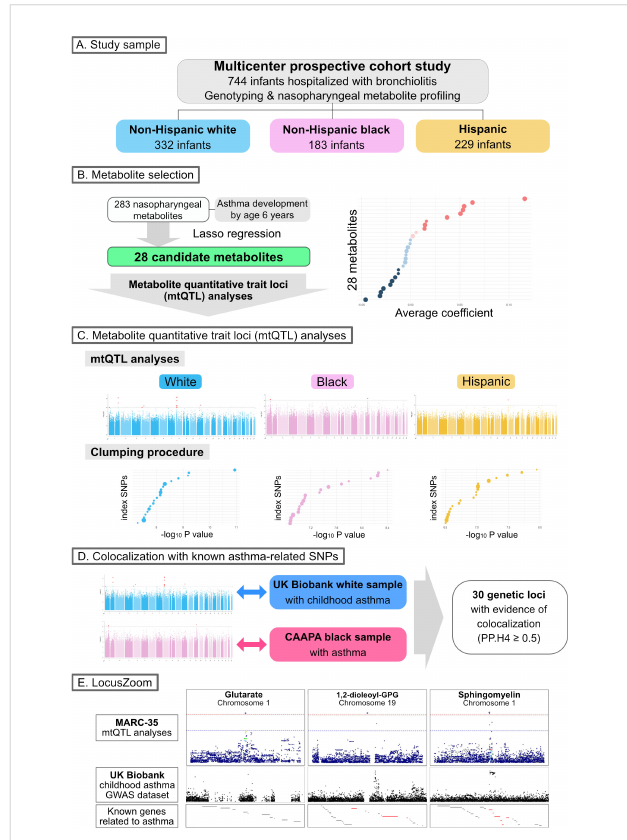
FIGURE 1 Analytic work fl ow of the study (A) . Of 744 infants (age <1 year) hospitalized with bronchiolitis, the current analysis investigated 744 infants — 332 (45%) were non-Hispanic white, 183 (25%) were non- Hispanic black, and 229 (31%) were Hispanics — who underwent both genotyping and nasopharyngeal metabolome pro fi ling. (B) . The association of 283 nasopharyngeal metabolites of the infants with asthma development by age 6 years was examined — by constructing Lasso regression models — to identify candidate metabolites for the downstream metabolite quantitative trait loci (mtQTL) analysis. (C) . The mtQTL analysis was performed to examine the association between 28 candidate metabolites and genotypes in each of the three major racial/ethnic subgroups of infants with bronchiolitis. The clumping procedure was also conducted to determine mtQTLs that are independent of each other. (D) . Bayesian colocalization analysis using summary statistics of the mtQTLs of MARC-35, UK Biobank (white sample with childhood asthma), and CAAPA (African-admixed sample with asthma) was conducted to identify shared genetic